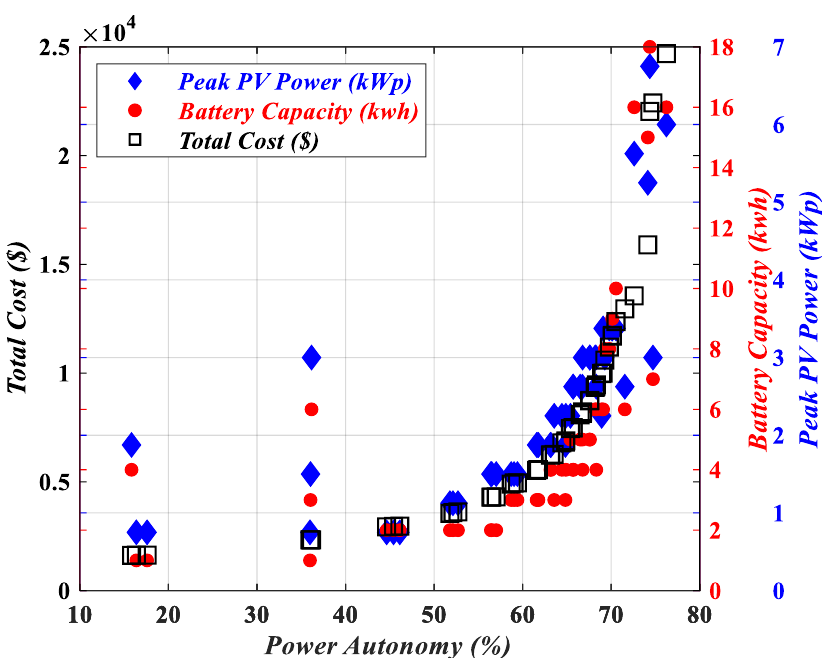
Figure 8. Total cost and power autonomy factor for a variety of PV panel installation areas and battery capacity values for Boujdour (commercial area).